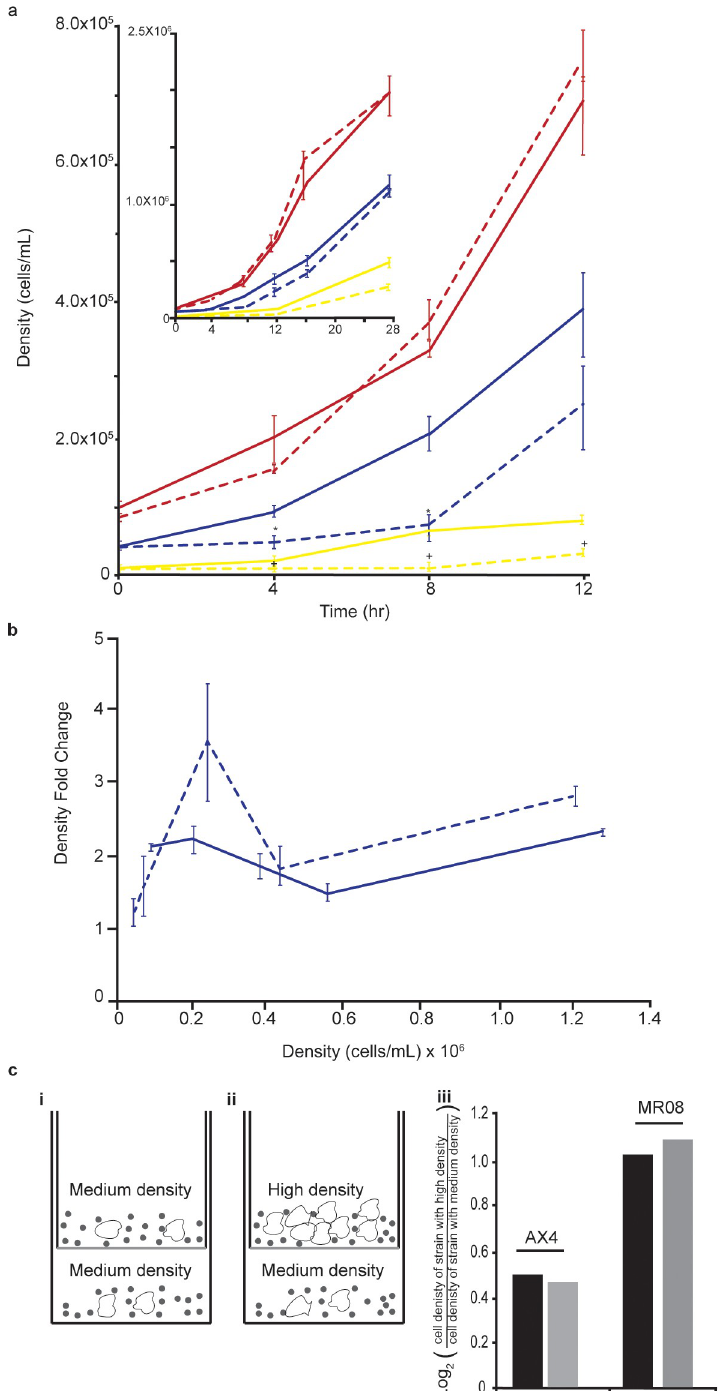
Fig 1. Cell density affects growth. (a) We placed D . discoideum cells in submerged cultures in association with K . pneumoniae at the following densities: yellow– 1x10 4 cells/mL, blue– 5x10 4 cells/mL, red– 1x10 5 cells/mL. We incubate the cultures and counted the amoebae at the indicated times. The graph shows the calculated cell density (y-axis, cells/ mL) as a function of time (x-axis, hours). Solid lines: wild type; dashed lines: MR08 mutant. Each data point represents the mean of three independent replications and the bars represent the standard error of the mean. The inset shows the full growth curve, including the 16hr and 26hr time points. � P � 0.05 for 5x10 4 cells/mL, + P � 0.05 for 1x10 4 cells/ mL; independent sample t-test for pair-wise comparisons between the wild type and the mutant at each time-point. (b)